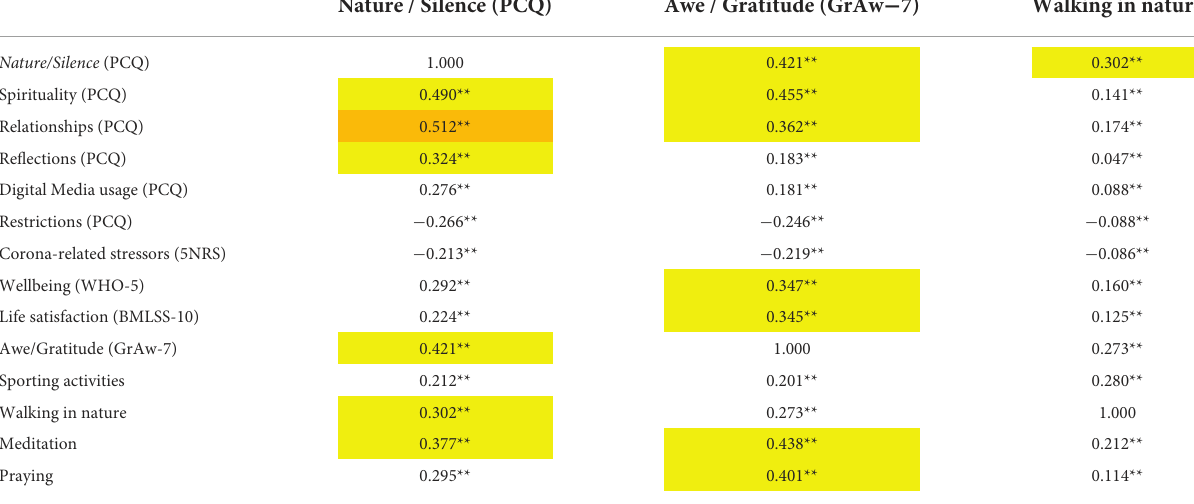
TABLE 4 Correlation analyses.